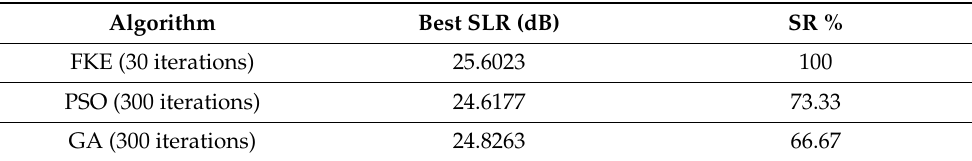
Table 1. The success rate (SR) of the proposed FKE algorithm, PSO, and GA for the sidelobe reduction using the magnitude of the excitation current (No. of runs = 30).